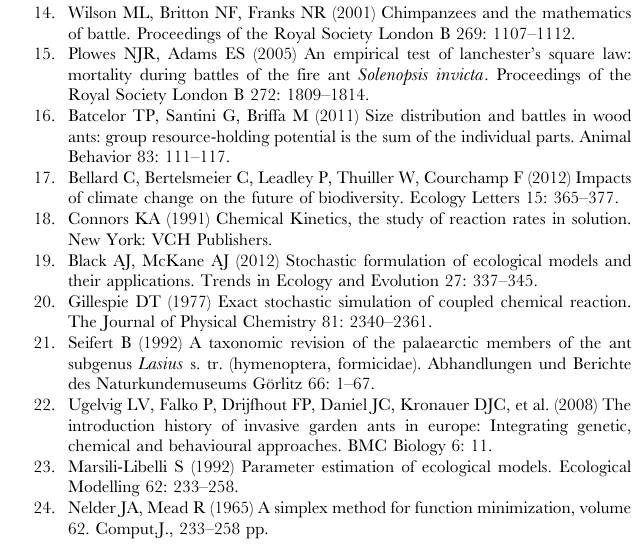
Figure S8 Experimental data and deterministic model for species ABB . The mean values of the chemical species ABB obtained from 20 experiments vs. the solution of the deterministic model by means of Simplex Flexible Algorithm(SFA). (TIFF) Figure S9 Experimental data and deterministic model for species ABBB . The mean values of the chemical species ABBB obtained from 20 experiments vs. the solution of the deterministic model by means of Simplex Flexible Algor- ithm(SFA). (TIFF) File S1 Supplementary material. Integration of the differ- ential equations. Gillespie implementation. Nonexistence of